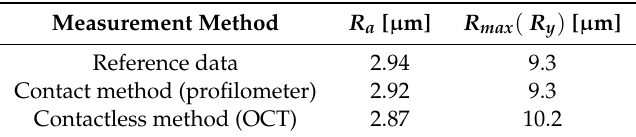
Table 3. Results of Code No. roughness measurement 178–601, serial no. 318411402, using contactless and contact